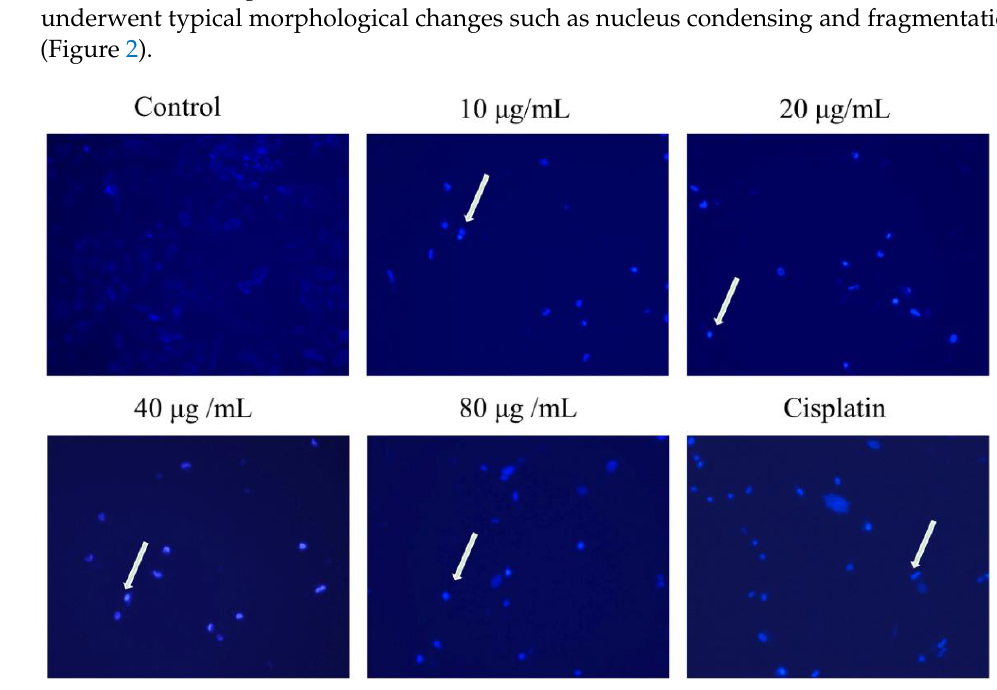
Figure 2. MCF-7 cell apoptosis staining. Hoechst 33,258 staining revealed changes in nuclear mor- phology. The phase contrast inverted microscopic images of the experimental groups (magnification, × 10). Apoptotic nuclei as indicated by the white arrow.